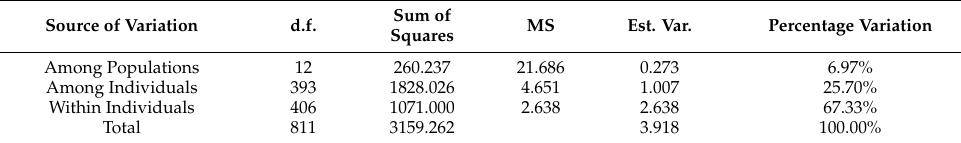
Figure 3. Estimated genetic clusters of thirteen R. philippinarum populations. The graph is based on the proportion of individuals per population in the inferred clusters according to STRUCTURE. Each of the three colors represents a different genetic cluster, and black lines separate the populations. Table 4. Analysis of molecular variance (AMOVA) in thirteen populations of R. philippinarum